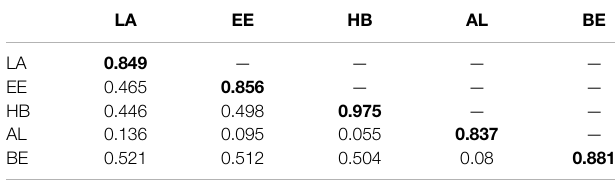
TABLE 6 | Fornell – Larcker criterion. LA EE HB BE